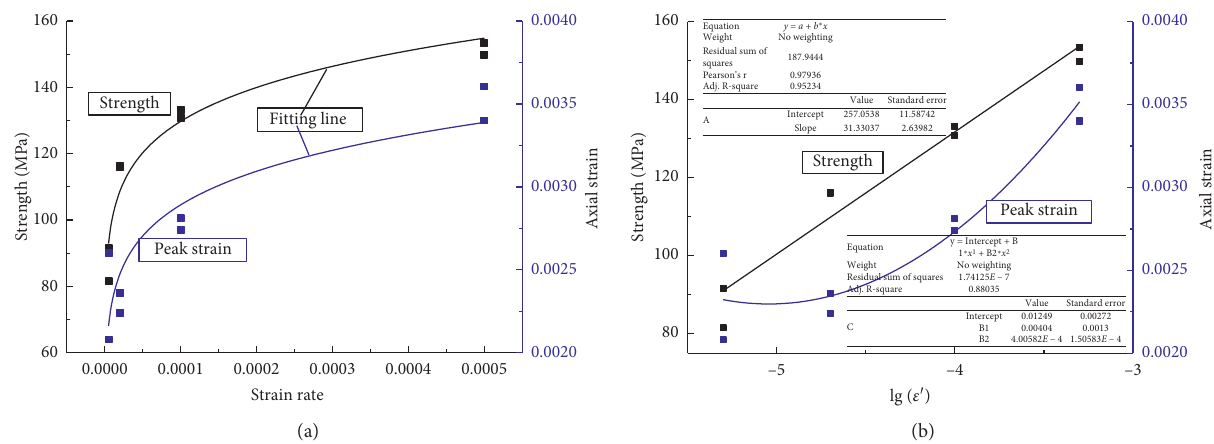
Figure 3: Relationship between strength and strain rate and between peak strain and strain